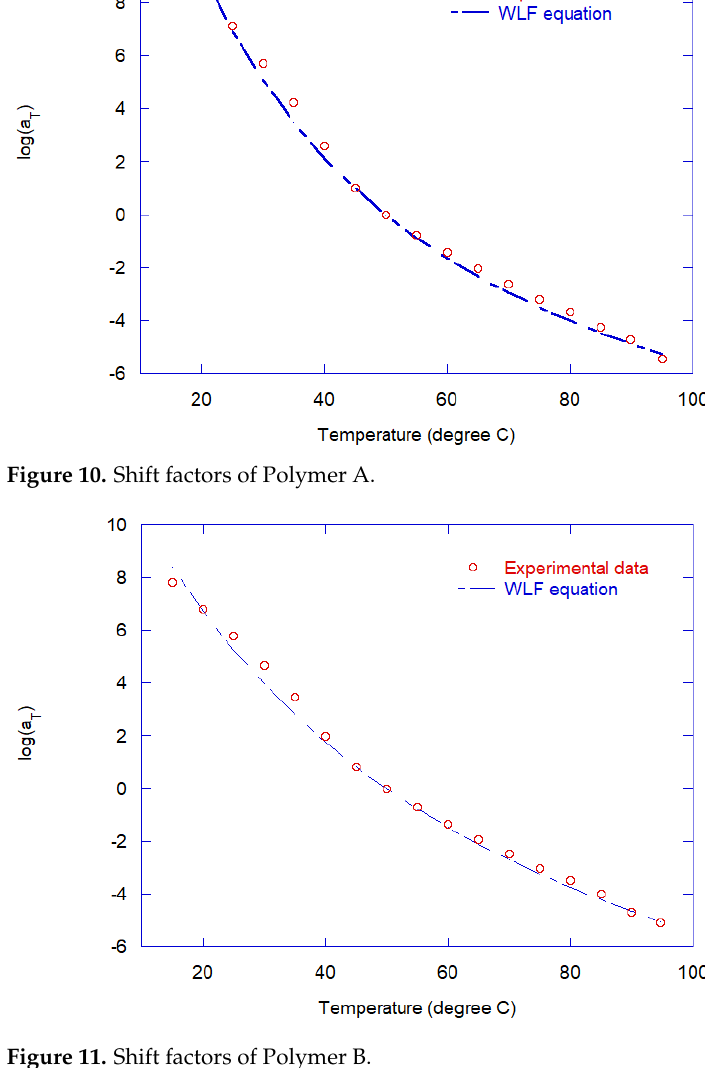
Figure 11. Shift factors of Polymer B.